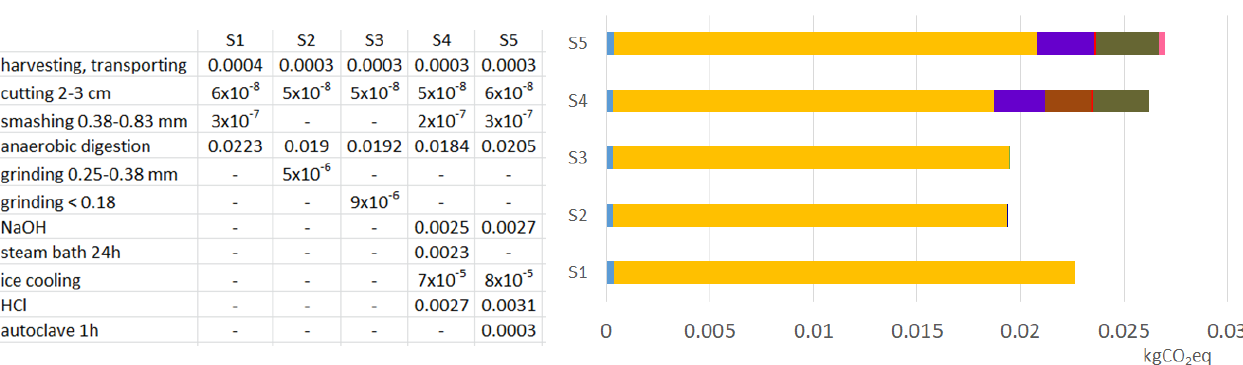
Figure 3. Global Warming Potential per 1 dm 3 of produced methane in the S1 – S5 processes.